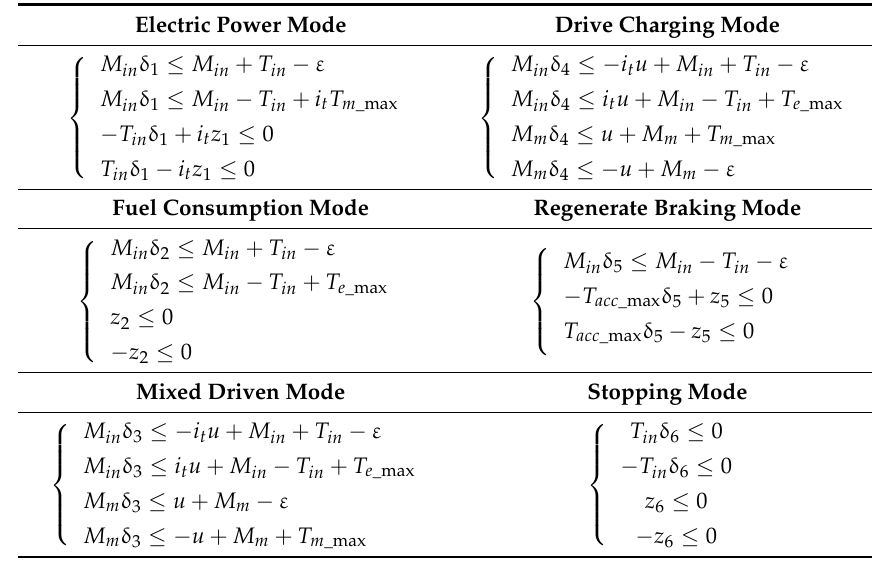
Table 4. Constraints during various operation mode for